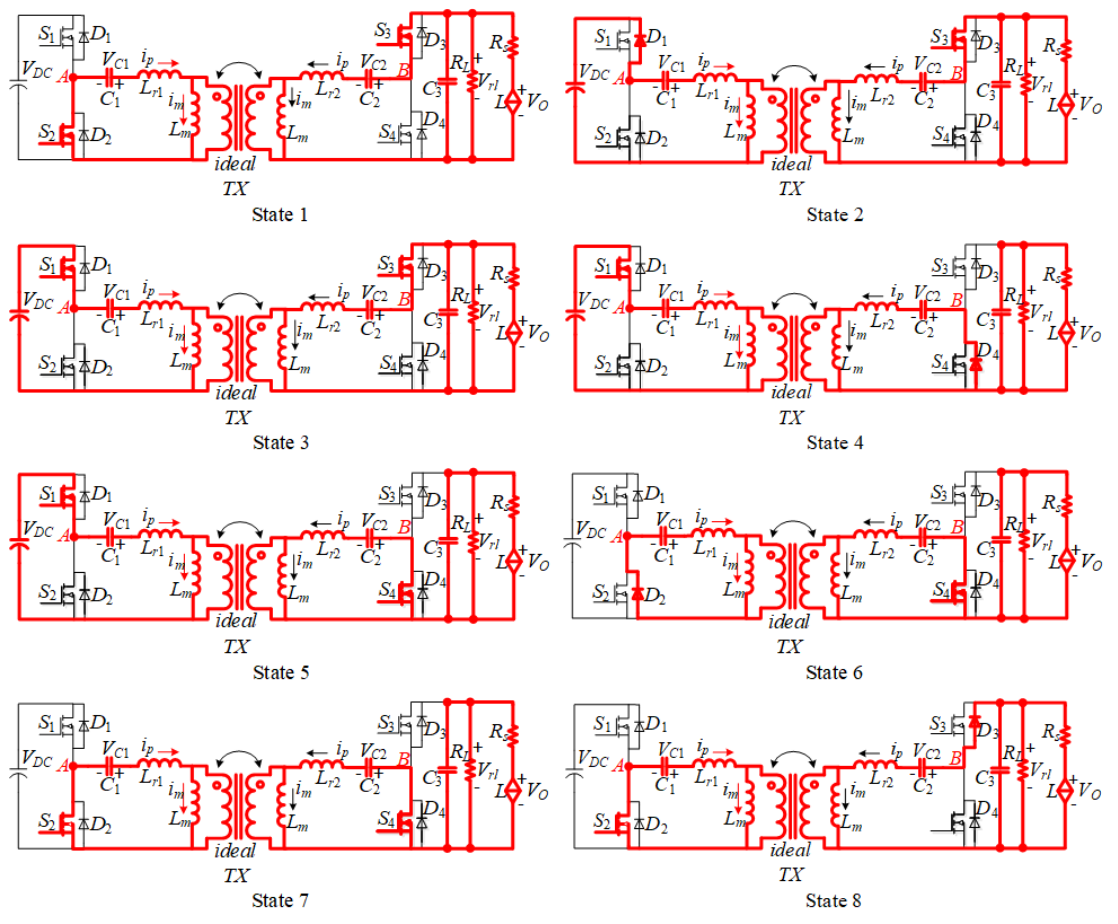
Figure 8. Reverse working mode state